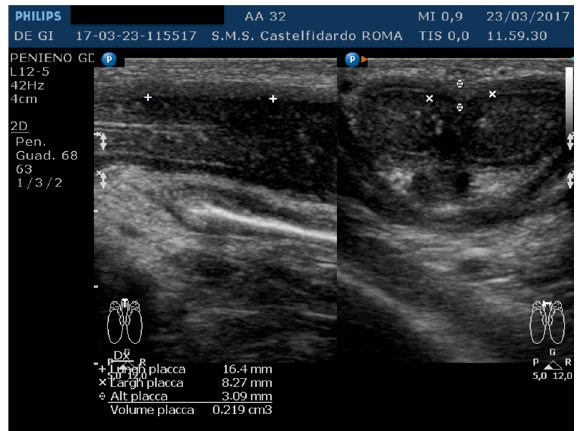
Figure 5. Ultrasonography of the penis before therapy (longitudinal and axial views).